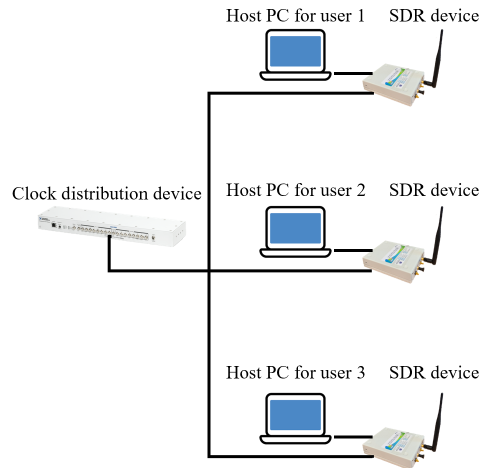
Figure 9. Configuration of host PCs for users, SDR devices for users’ transmitters (TXs), and clock distribution